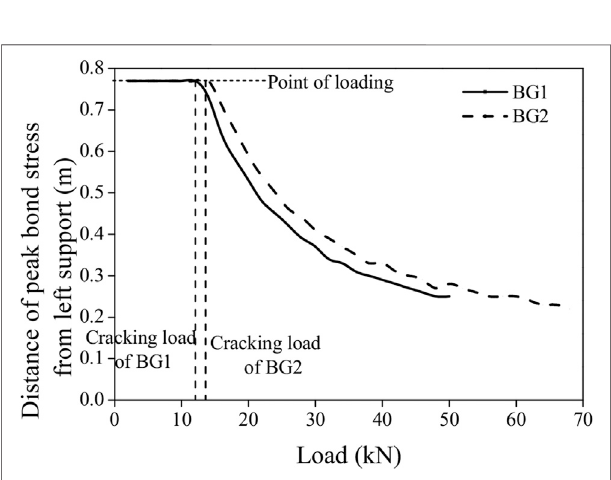
FIGURE 12 | Distance of the peak bond stress from the left